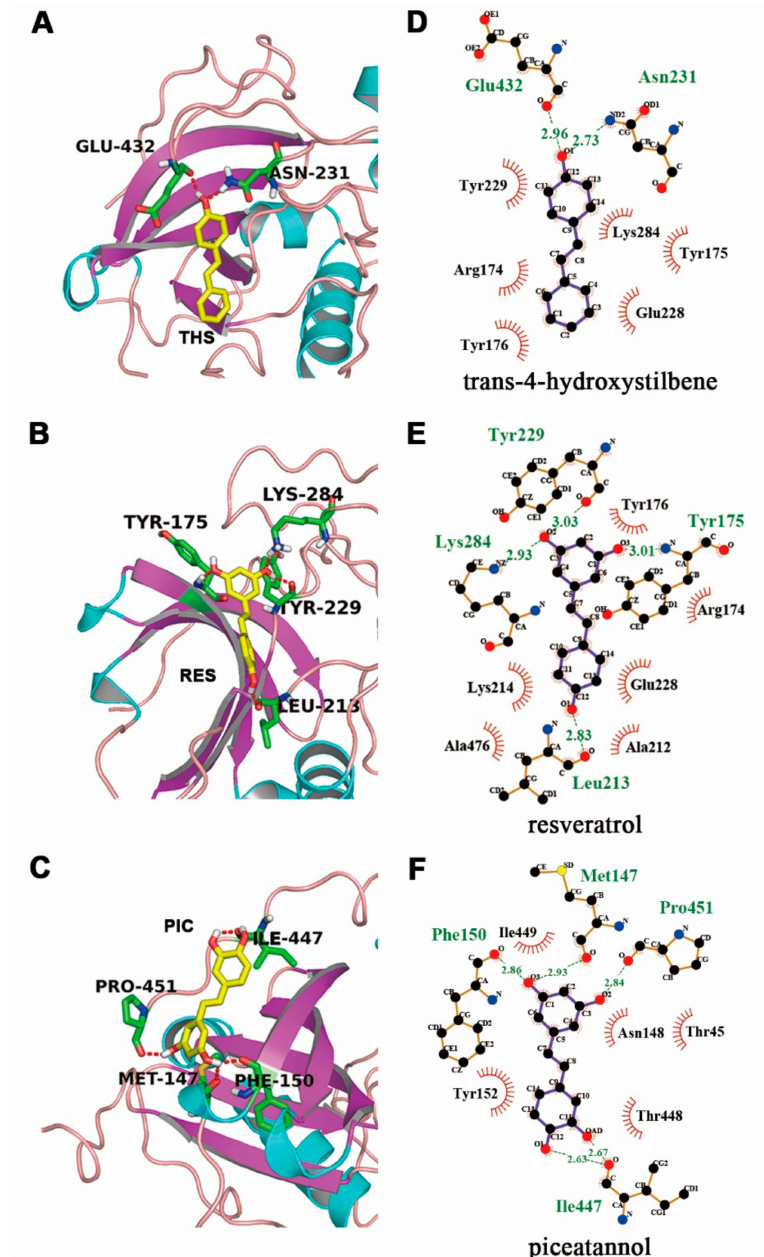
Figure 6. Molecular docking conformation of Akt protein binding with ( A ) trans -4-hydroxystilbene (THS), ( B ) resveratrol (RES), and ( C ) piceatannol (PIC). ( D – F ) Two-dimensional plots of the hydrophobic interactions between ligands and Akt protein. The atoms are color-coded as follows: carbon, black; nitrogen, blue; oxygen, red; and sulphur, yellow. The ligand’s bonds are shown in purple, and those of the protein residues are in orange. Hydrogen bonds between protein and ligand are represented by green dotted lines, lengths in angstroms; residues involved in nonbonded contacts with the ligand are represented by the arcs, with corresponding arcs on the relevant atoms of the